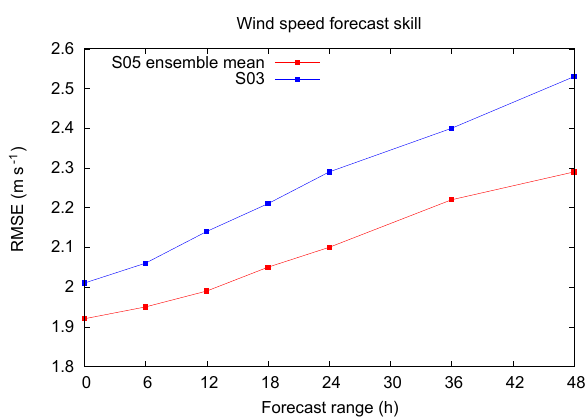
Figure 4. Verification of wind speed. Average RMSE between model and observations for eight coastal meteorological stations in the Baltic Sea